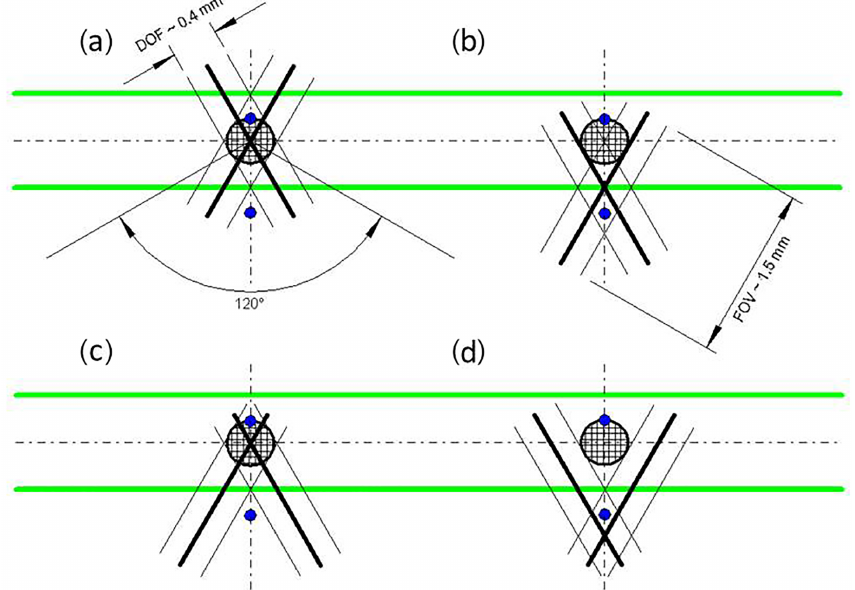
Figure 8. Schematics of the alignment strategy for the zoom lens focus. Ideal overlap between the two zoom lens fields of view (FOVs) and the trigger sensing area (a) . The trigger sensing area is represented by the hatched area centered in the laser beam diameter (the edges of the laser beam are indicated by the green lines). The positions of the particle when entering the sensing area and after the camera shutter delay are shown as blue dots, assuming an airspeed of 200ms − 1 . Note that the particle is already at the edge of the FOV and outside the depth of field (DOF) of both zoom lenses when the camera shutters open. Displacement of the FOVs relative to the sensing area by about 0.4mm to compensate for the particle movement during the shutter delay (b) . Zoom lens focus adjustment on a slowly moving particle in the laboratory (c) . Focus adjustment on a fast moving particle during aircraft measurements (d)